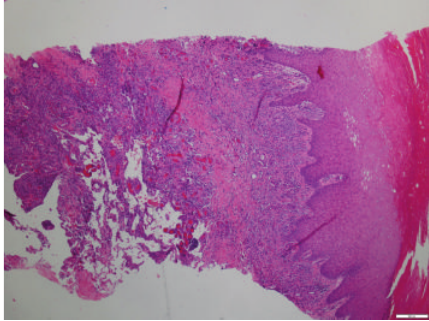
Figure 4: Positivity for vascular marker